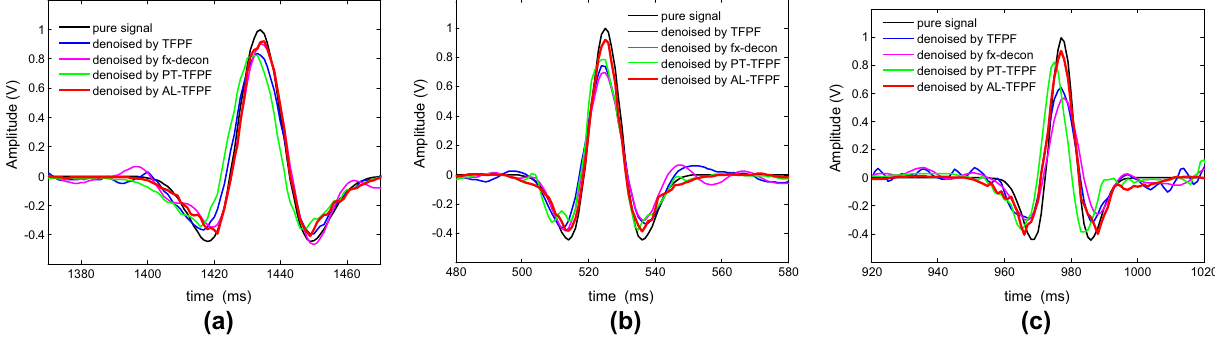
Fig. 11 a Result of 25-Hz synthetic seismic signal. b Result of 35-Hz synthetic seismic signal. c Result of 45-Hz synthetic seismic